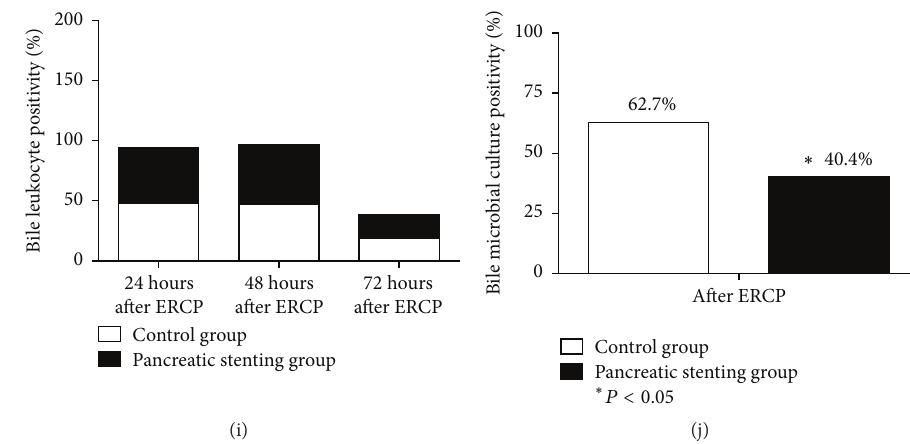
Figure3:Follow-uplaboratorydata:blood(a)leukocyteand(b)neutrophilcounts;serumlevelsof(c)alanineaminotransferase,(d)aspartate aminotransferase, (e) gamma-glutamyl transpeptidase, (f) total bilirubin, (g) direct bilirubin, (h) alkaline phosphatase, (i) bile leukocyte positivity, and (j) bile microbial